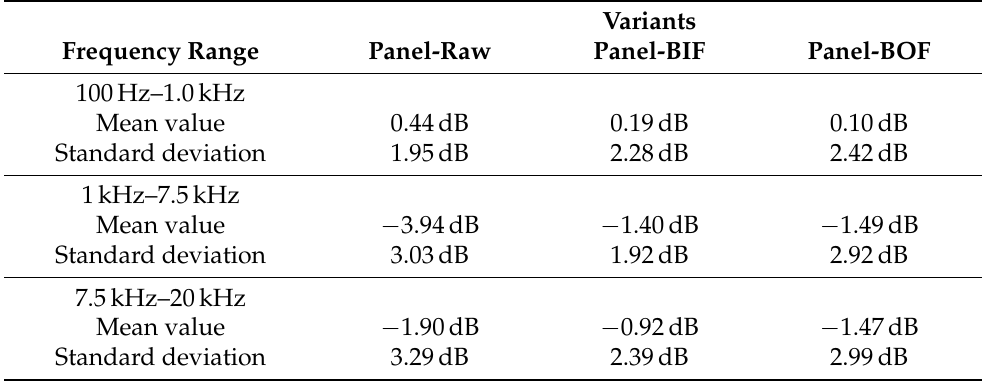
Table 2. Mean value and standard deviation of the DI for three different frequency ranges calculated for all three